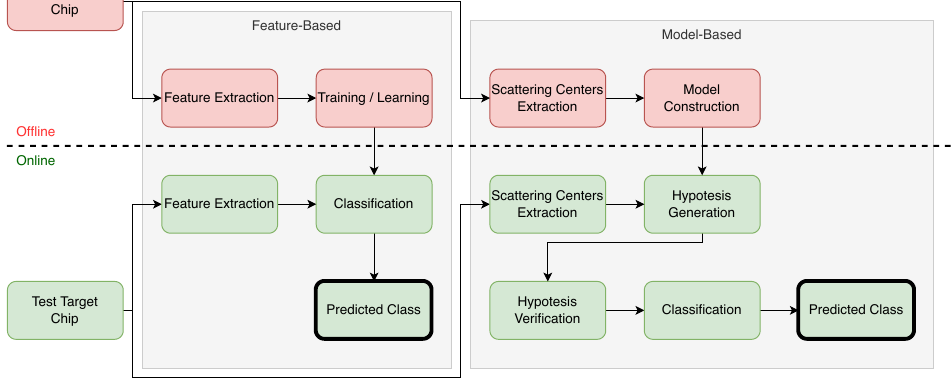
Figure 1. Feature and model-based classification approaches. Blocks in red and green are processed offline and online,